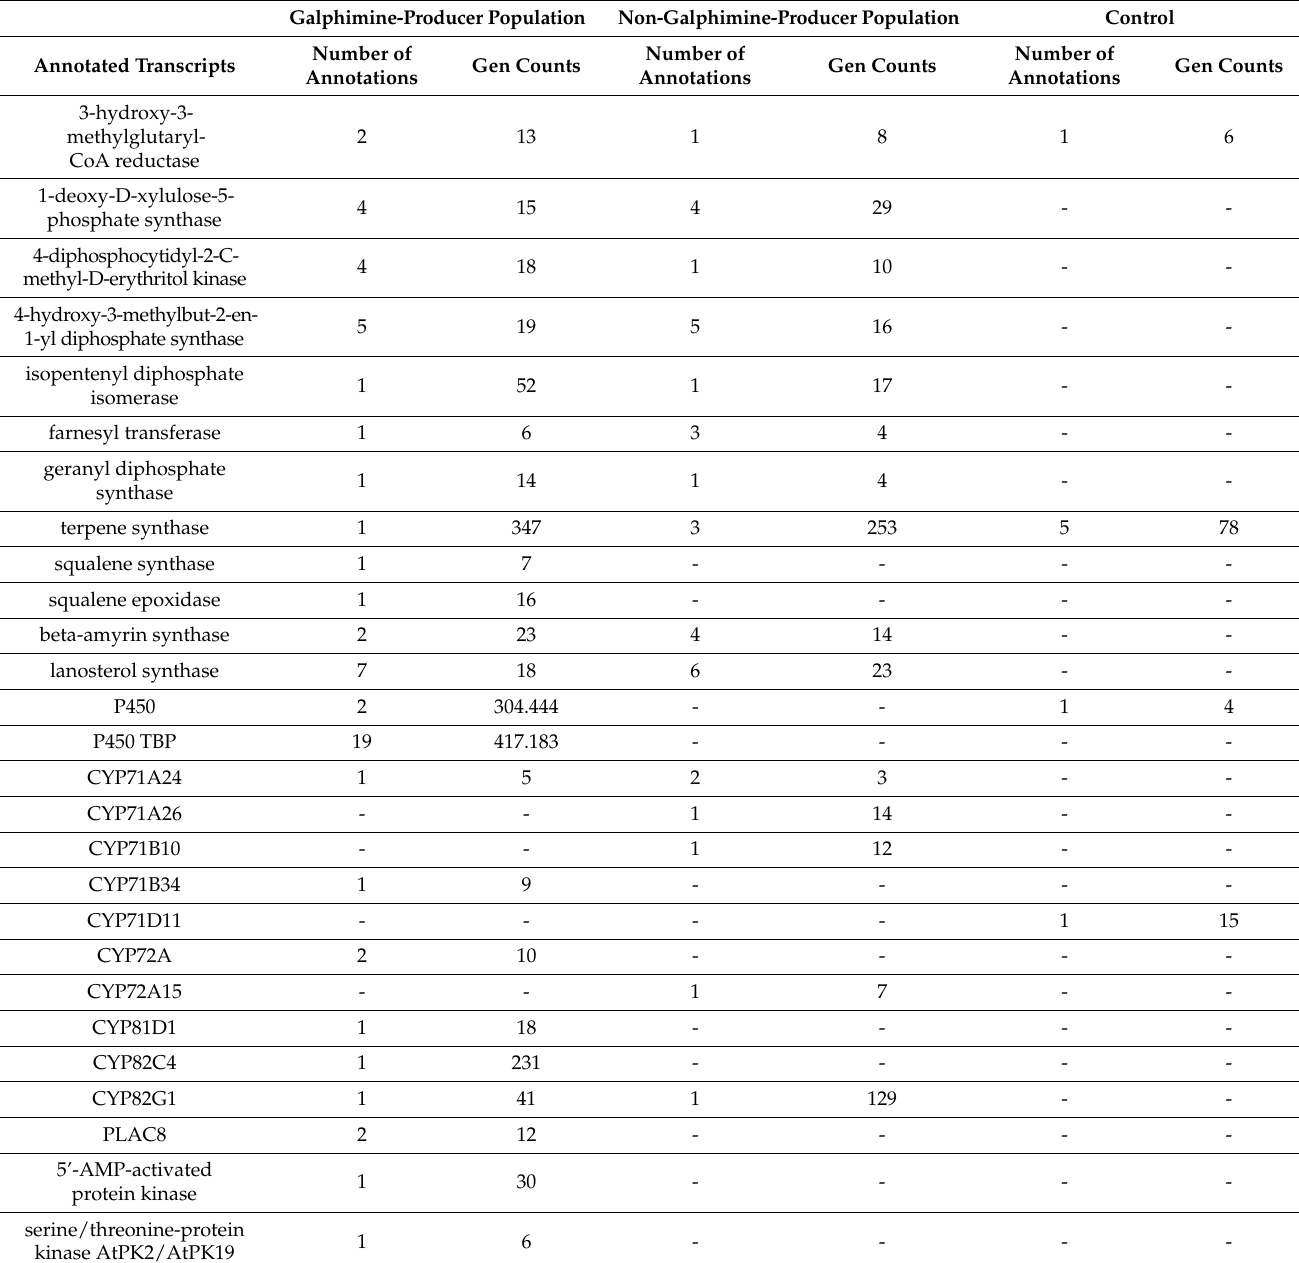
Table 2. Annotation and gene counts of transcripts related to terpene synthesis of two populations of Galphimia